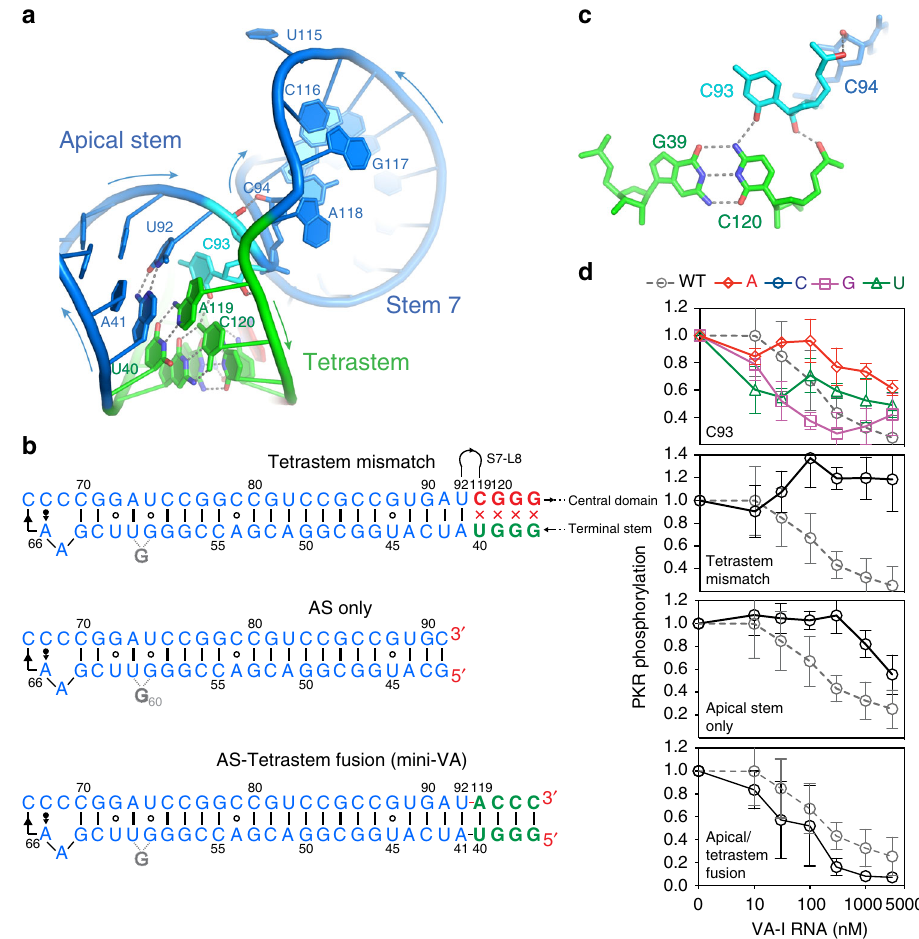
Fig. 3 Stacked apical and tetra-stems from the PKR-inhibitory core. a Structure of the three-helix junction involving the coaxially stacked apical stem and tetrastem, and Stem 7. The junctional C93 is shown in cyan. b Secondary structures of a mutant VA-I harboring a mismatched tetrastem, a truncated apical stem (AS)-only construct, and a topologically engineered mini-VA RNA where the apical stem is fused to the tetrastem. The RNA termini are highlighted in red. c Structure of the G39 – C120·C93 base triple. Note the two additional backbone hydrogen bonds from C93 to C120 and C94 connecting the tetrastem to Stem 7. d Effects of C93 substitutions and mutants in c on PKR inhibition. Individual titration curves for singly substituted mutants are colored based on the identity of the new nucleobase (A: red diamonds; C: blue circles; G: purple squares; U: green triangles). Error bars represent s.d. from three independent